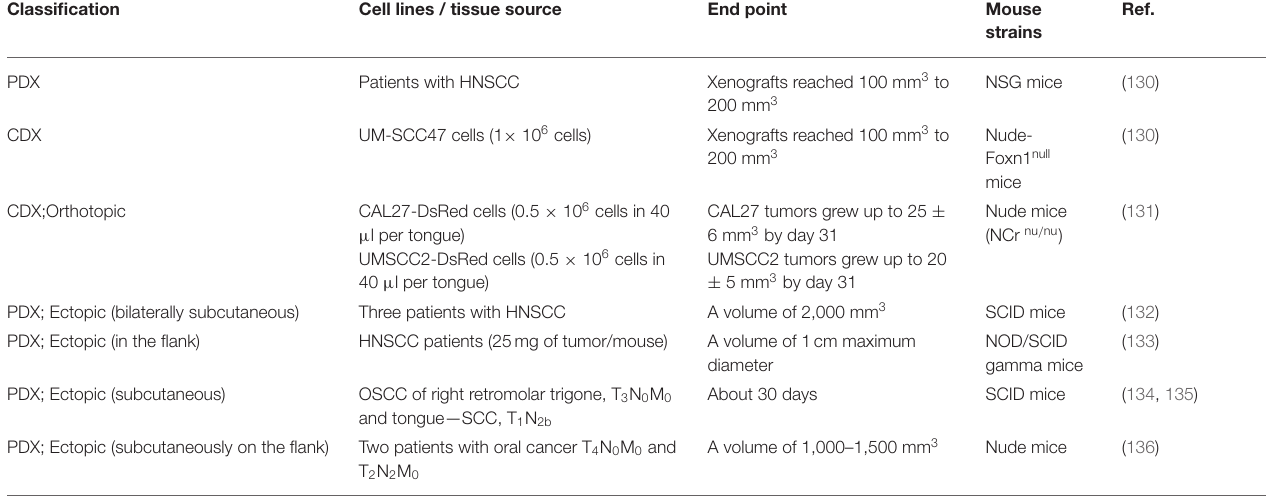
TABLE 4 | Xenograft OSCC mouse